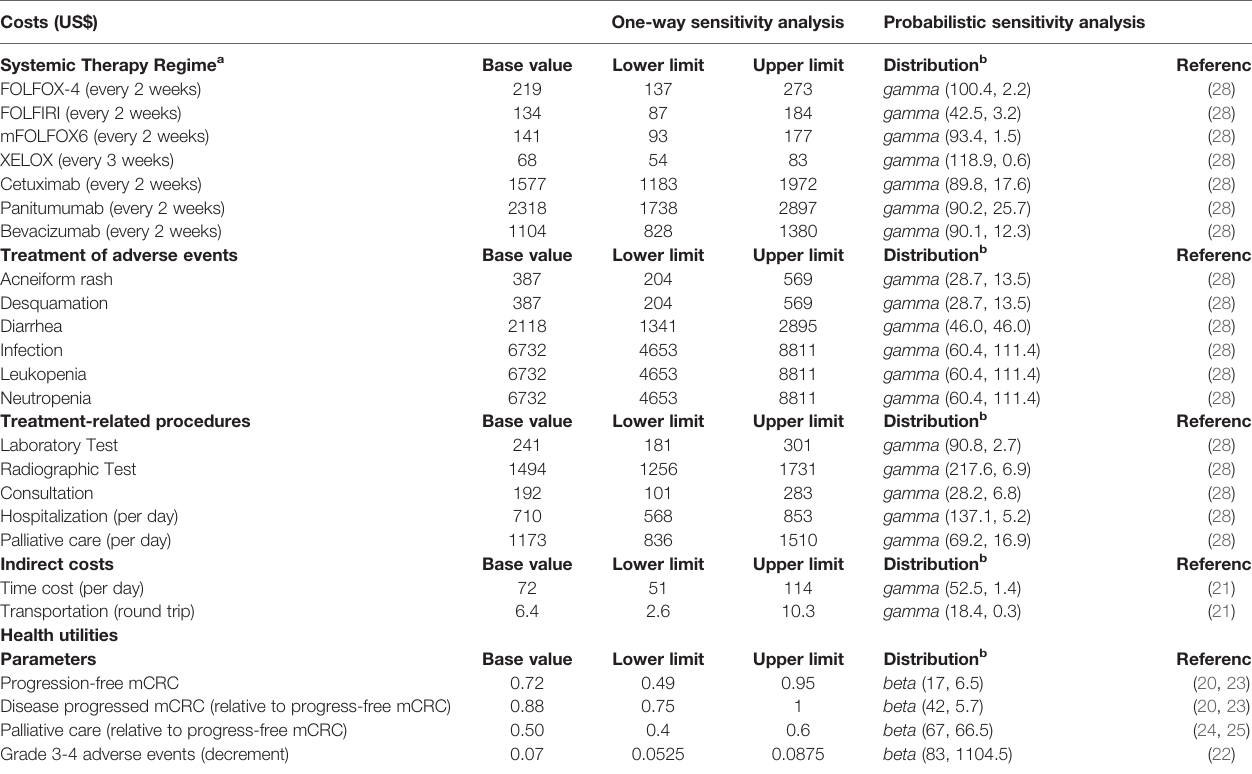
TABLE 1 | Economic and health utility parameters and corresponding distributions for probabilistic sensitivity analysis.